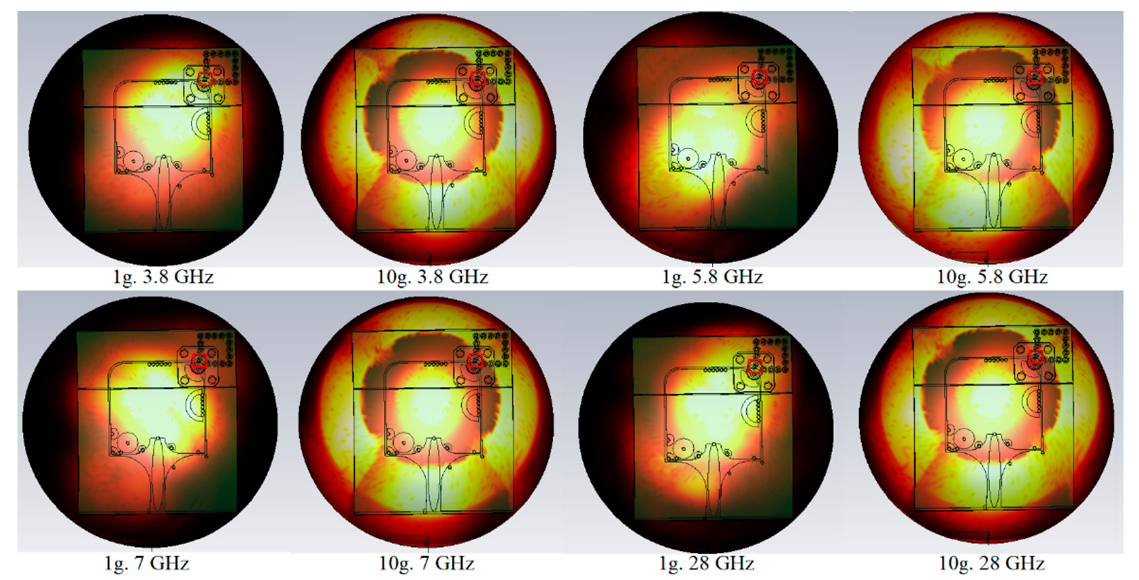
Figure 5. Specific absorption rate (SAR) variation on breast at different frequency and standards (1 g, 10 g).